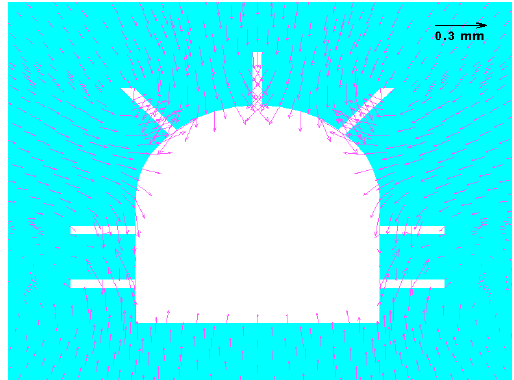
Figure 6. Displacement distribution of surrounding rock.